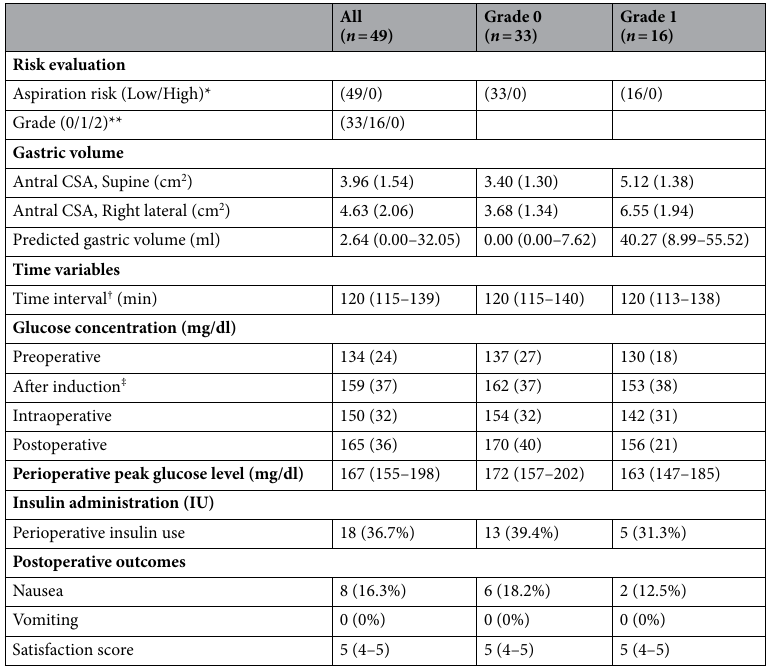
Table 2. The outcome assessment after carbohydrate loading in diabetic patients before general anesthesia. Data are presented as mean (SD), median (IQR), or number (%). CSA, cross-sectional area; PACU, post anesthesia care unit; IU, International Unit. *The aspiration risk was classified as follows: Low risk—grade 0 or 1, or estimated total gastric fluid volume was ≤ 1.5 ml/kg; High risk—grade 2, or estimated total gastric fluid volume was > 1.5 ml/kg. **The grades were defined as ‘antral grading system’ based on ultrasound assessment of gastric content and volume depending on position; grade 0—the antrum appeared empty on both supine and right lateral decubitus positions; grade 1—gastric fluid was visible on the right lateral decubitus position only, suggesting a small fluid volume. † Time interval was defined as the duration between carbohydrate loading time and the time of assessment of antrum. ‡ One missing value in the grade 0